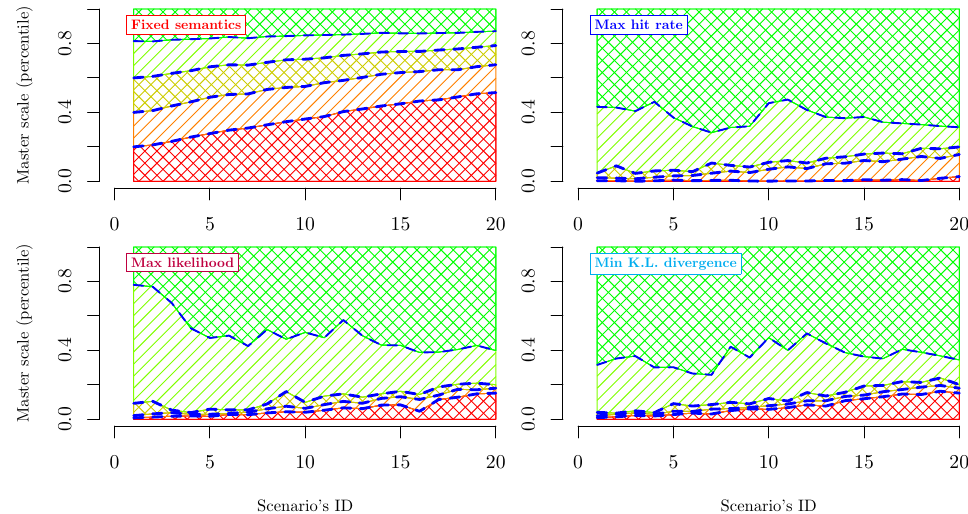
Figure 3. Master scale’s partition across the considered scenarios. Each panel depicts the effects of choosing a different optimality criterion among the ones defined in Section 2.2.